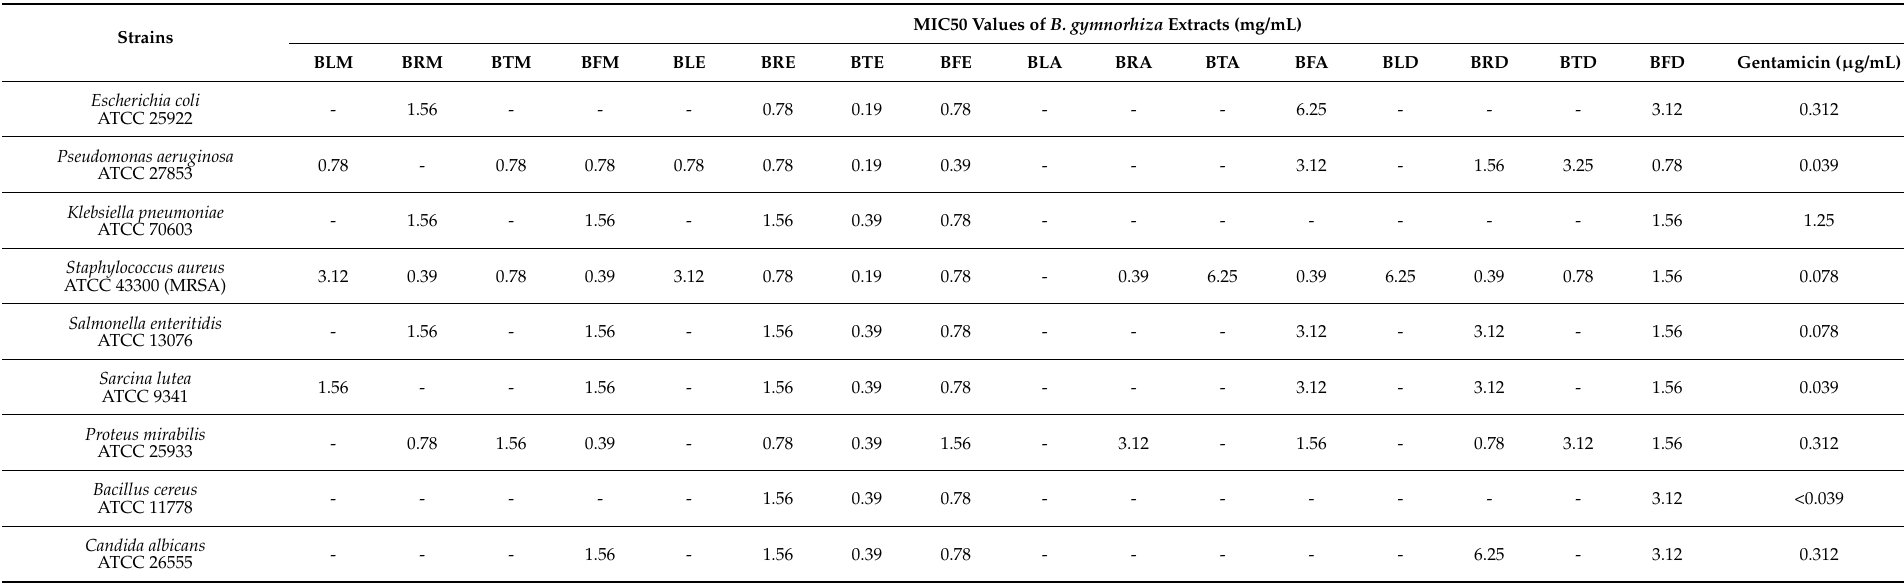
Table 2. Antimicrobial activity of B. gymnorhiza extracts (MIC50 values in mg/mL) against nine